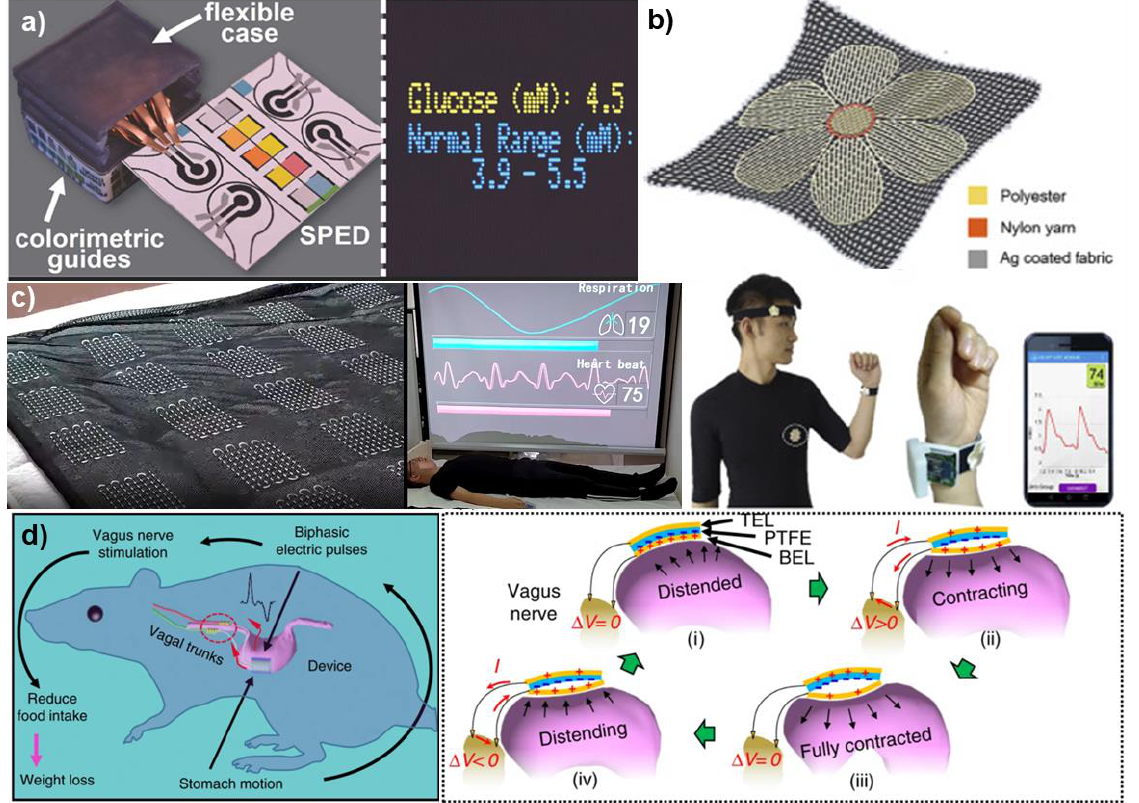
Figure 3. Examples of TENG-powered sensor applications. ( a ) A self-powered electrochemical device based on a paper microfluidic sensor is integrated with a potentiostat to give a user-friendly glucose reading, figure adapted from [21], ( b ) A flexible, textile-based pressure sensor is used as a user-friendly wearable device for monitoring pulse wave signals and wirelessly transmitting them figure adapted from [65]. ( c ) A smart textile sensing unit uses triboelectrification and electrostatic induction to monitor respiration and heart rate during sleep, figure adapted from [64]. ( d ) An implanted vagus nerve stimulation system is biocompatible and self-powered. As the stomach is enlarged, this triggers a current along the vagus nerve which helps to control the overeating, figure adapted from [63].